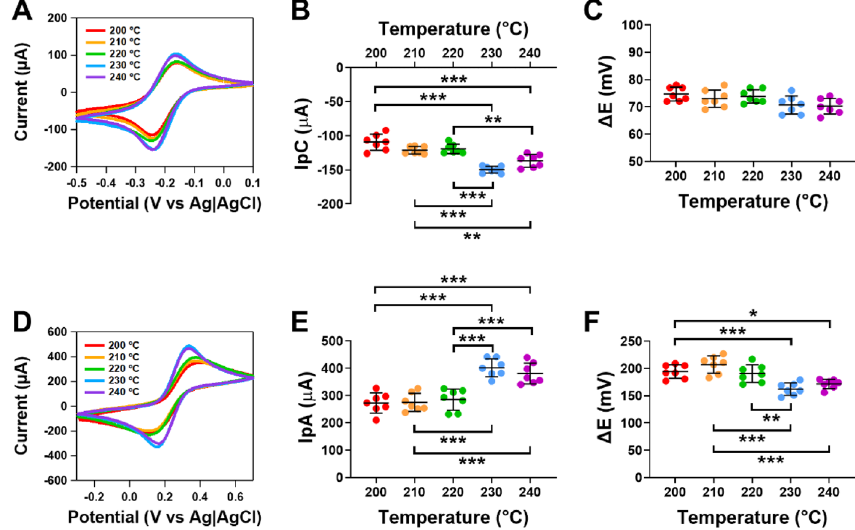
Figure 3. Responses of 3D printed CB/PLA electrodes at different extruder temperatures on outer and inner sphere redox probes. ( A ) Representative cyclic voltammograms of 1 mM ruthenium hexaamine in 1 M KCl at 0.05 V s −1 , ( B ) Cathodic peak current, ( C ) ΔE of ruthenium hexaamine ( D ) representative cyclic voltammograms of 5 mM ferricyanide in 1 M KCl at 0.05 V s −1 , ( E ) anodic peak current and ( F ) ΔE of ferricyanide. The nozzle diameter was 0.6 mm and the heated bed temperature was 50 °C. Data shown as mean ± SD, where n = 7, * p < 0.05, ** p < 0.01, *** p <